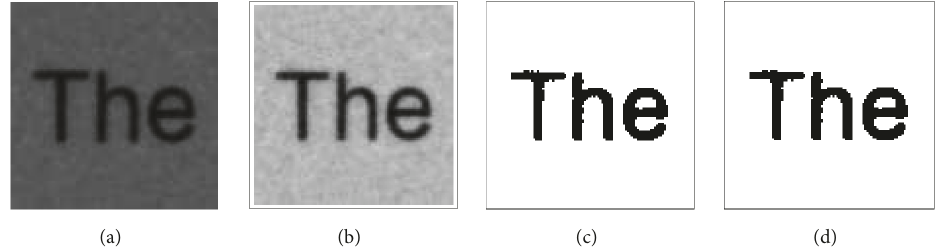
Figure 6: Figures depicting results obtained at increasing time using the current method and 𝛼 = 0.2 . (a) The original image, (b) processed image at 𝑡 = 0.01 , (c) processed binary image at 𝑡 = 0.001 , (d) processed binary image at 𝑡 = 0.01 .